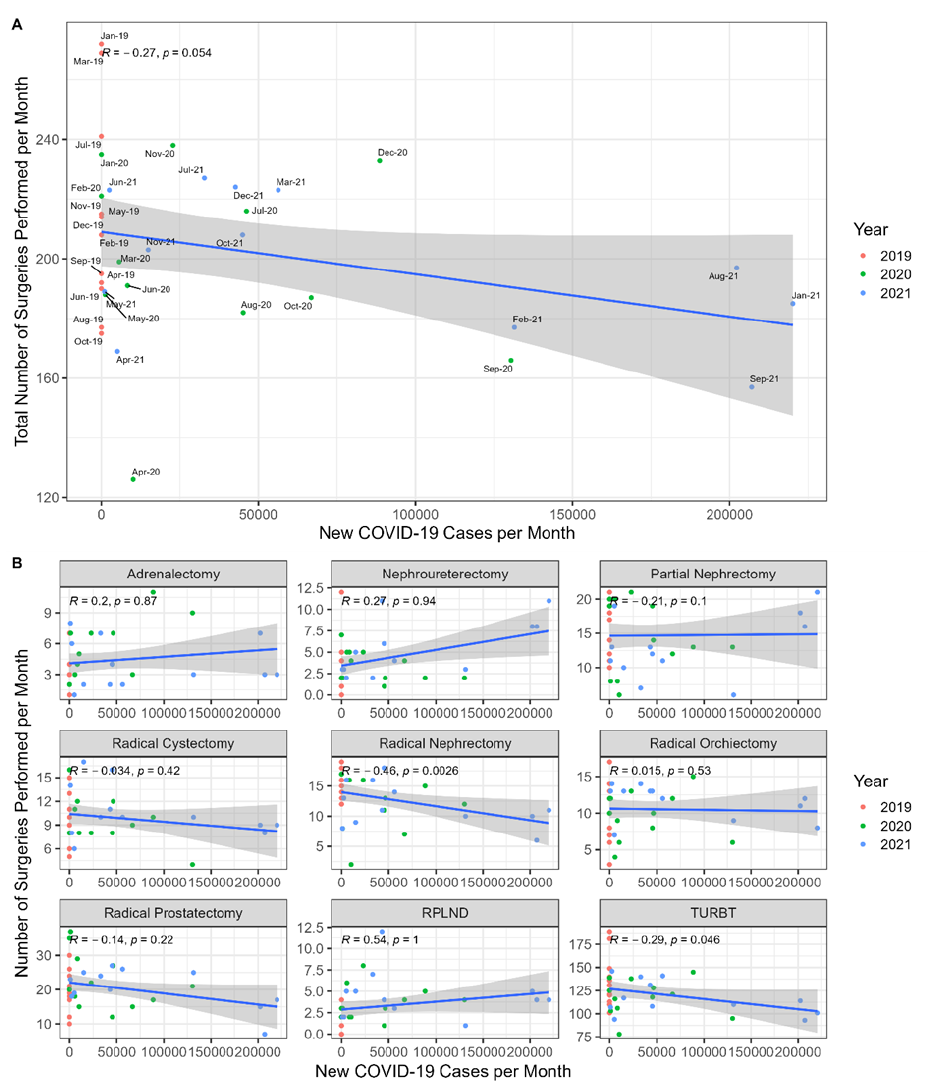
Figure 2. ( A ) Correlation between the total number of urologic surgeries per month and the number of new COVID-19 cases per month. ( B ) Subgroup analysis per surgery